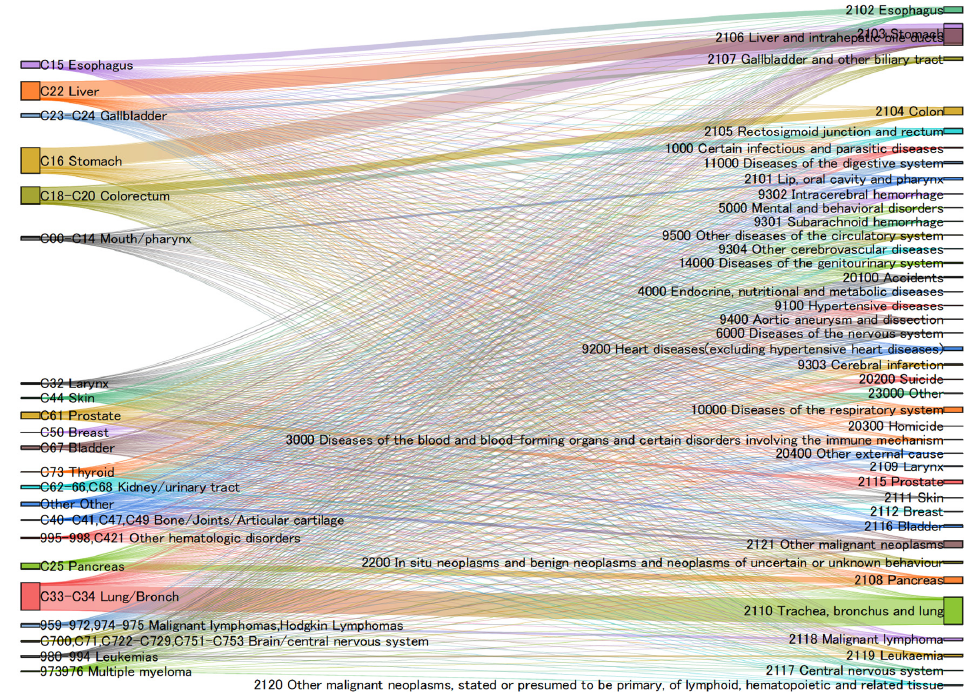
Figure A1. Relationships between cancer sites and cause of death (male patients).